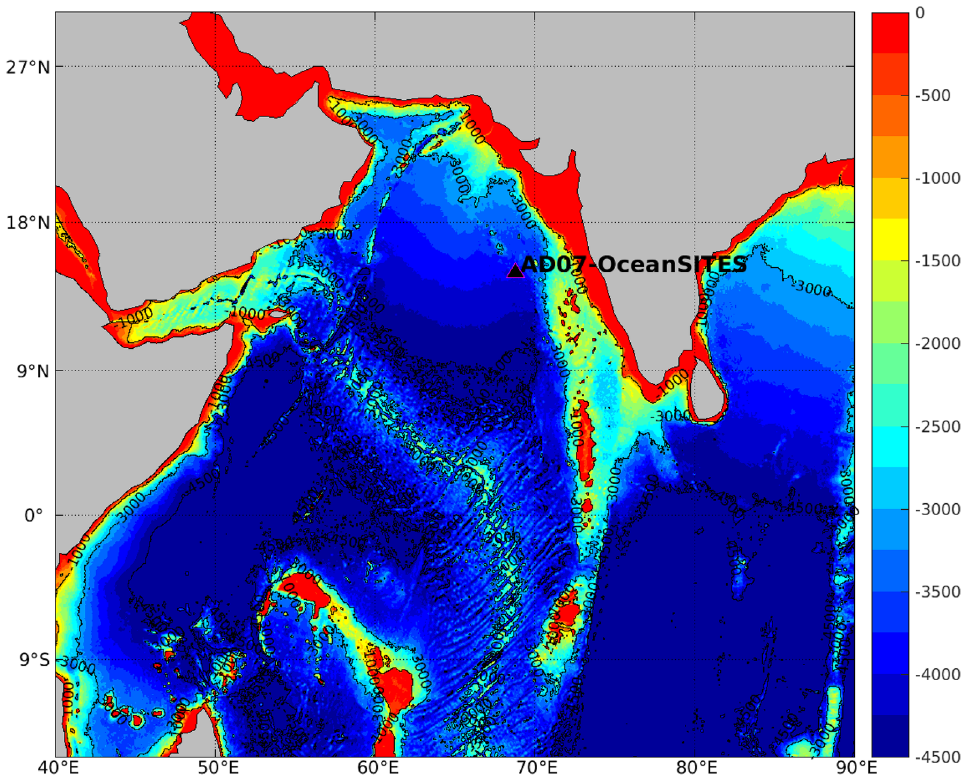
Figure 1. Depth of seabed (in meters) in the Arabian Sea and the surrounding oceanic regions based on ETOPO1